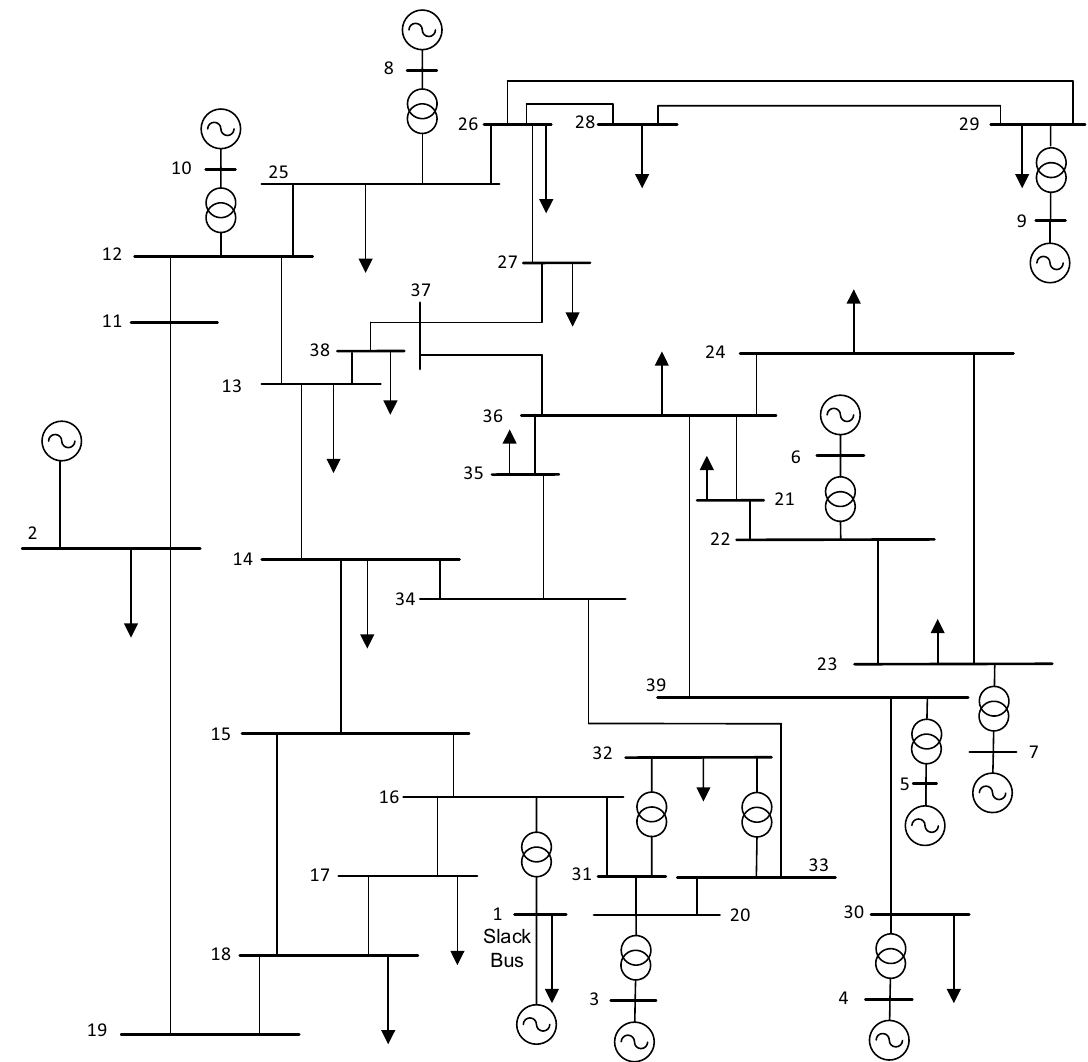
Figure 6. The single line diagram of the New England 39-bus system.